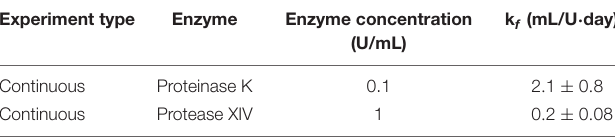
Water Annealing Time: 6 h.